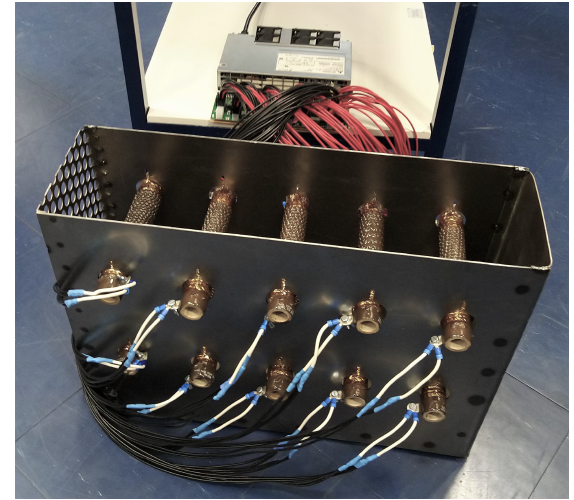
Figure 8. Modular passive load for emulating DC power